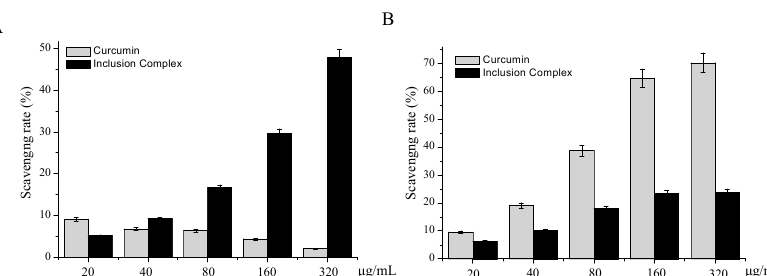
Figure 6. ABTS radical scavenging rate ( A ) and DPPH radical scavenging rate ( B ) of curcumin/ β -cyclodextrin polymer inclusion complex or curcumin with different concentrations. Values expressed are means ± SD of triplicates.